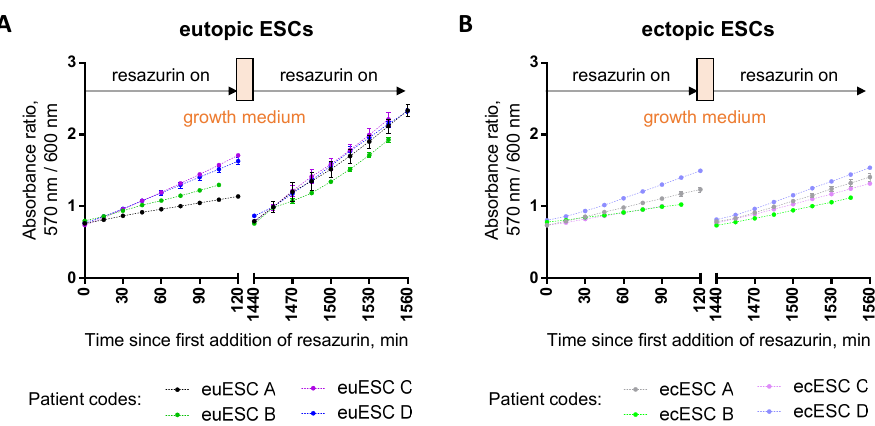
Figure 10. Resazurin assay in primary eutopic ( A ) and ectopic ( B ) endometrial stromal cells (ESCs) treated with 0.1% DMSO. The first measurement (120 min duration) was carried out at 24 h post- seeding; next, the cells were rinsed with PBS and kept in the growth medium in the CO 2 incubator at 37 ◦ C overnight, followed by the second measurement (also 120 min duration). Detected optical characteristic: absorbance ratio (570 nm/600 nm); measurements were carried out at 40 µ M resazurin. In each graph, results are shown for ESCs isolated from the samples of four different patients; for each patient, an average of triplicates ± SEM is